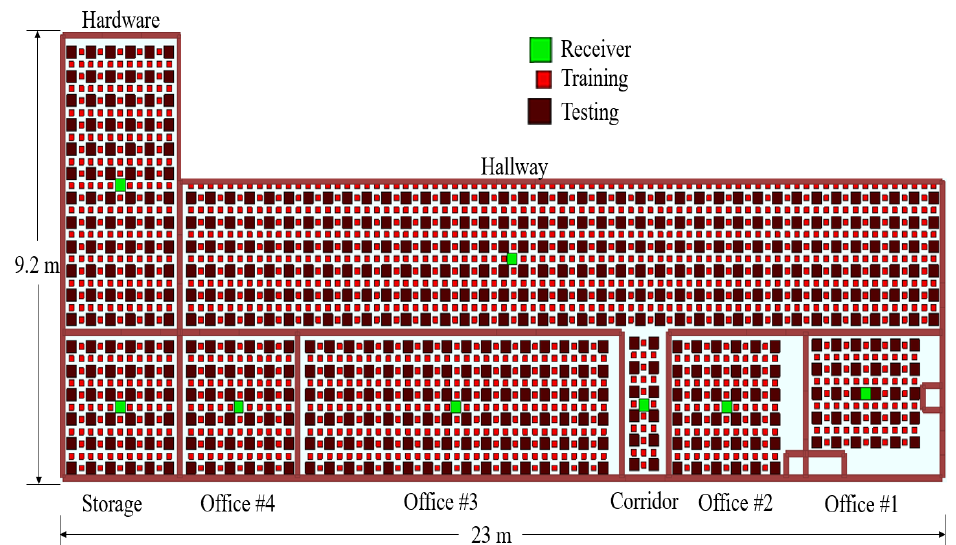
Figure 3. Simulated indoor environment used to evaluate IPS algorithms in the literature and compare to the proposed 3D CSI